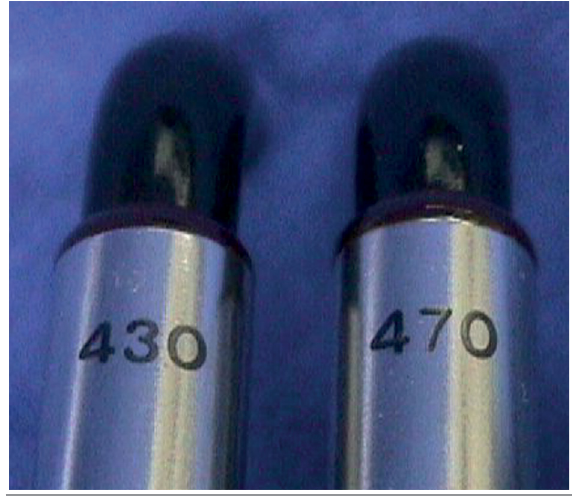
Figure 18. 430 and 460 nm tips used in early PAC lights.